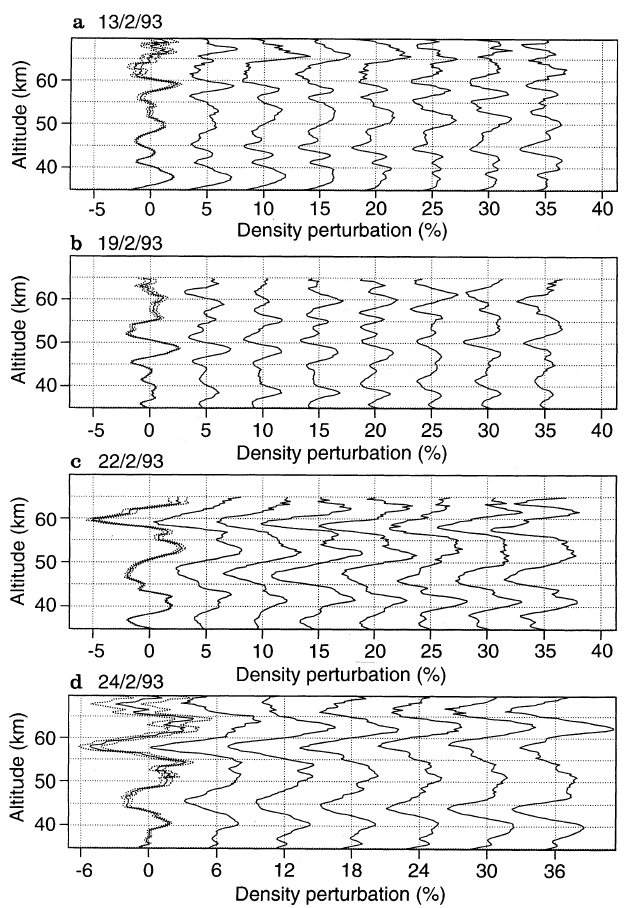
Fig. 5a–d. Profiles of the mean potential energy per unit mass derived from measurements made on the nights of a 26 and 29 June 1995, b 27 and 28 June 1995, c 13 and 19 February 1993 and d 22 and 24 February 1993. The uncertainities in the estimated energies are shown for the full-line profiles by heavy bars at heights of 40, 50 and 60 km which correspond to one